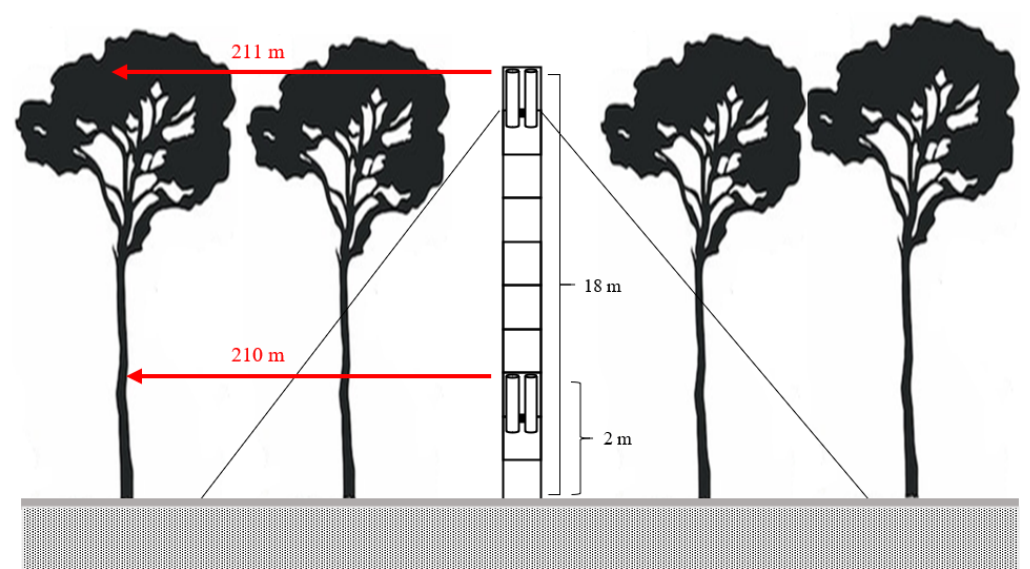
Figure 2. Schematic diagram of the lower (ground) and upper (tower) CRNS detectors in the Acacia mearnsii plantation in the Two-Streams Catchment.